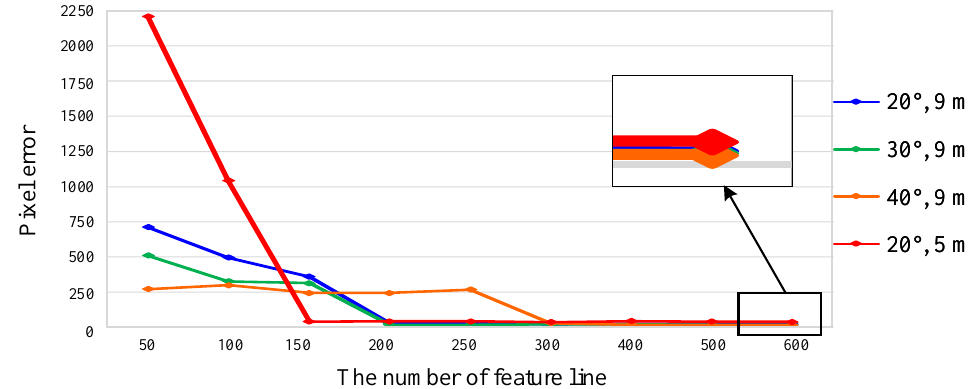
Figure 14. Pixel error under different camera pitch angle, deployment height and the number of feature lines. Blue, red and orange curves are the performance of different pitch angles with different number of feature lines based on the same deployment height of 9 m. Blue and green curves are the performance of different deployment with different number of feature lines based on the same pitch angle 20 ◦